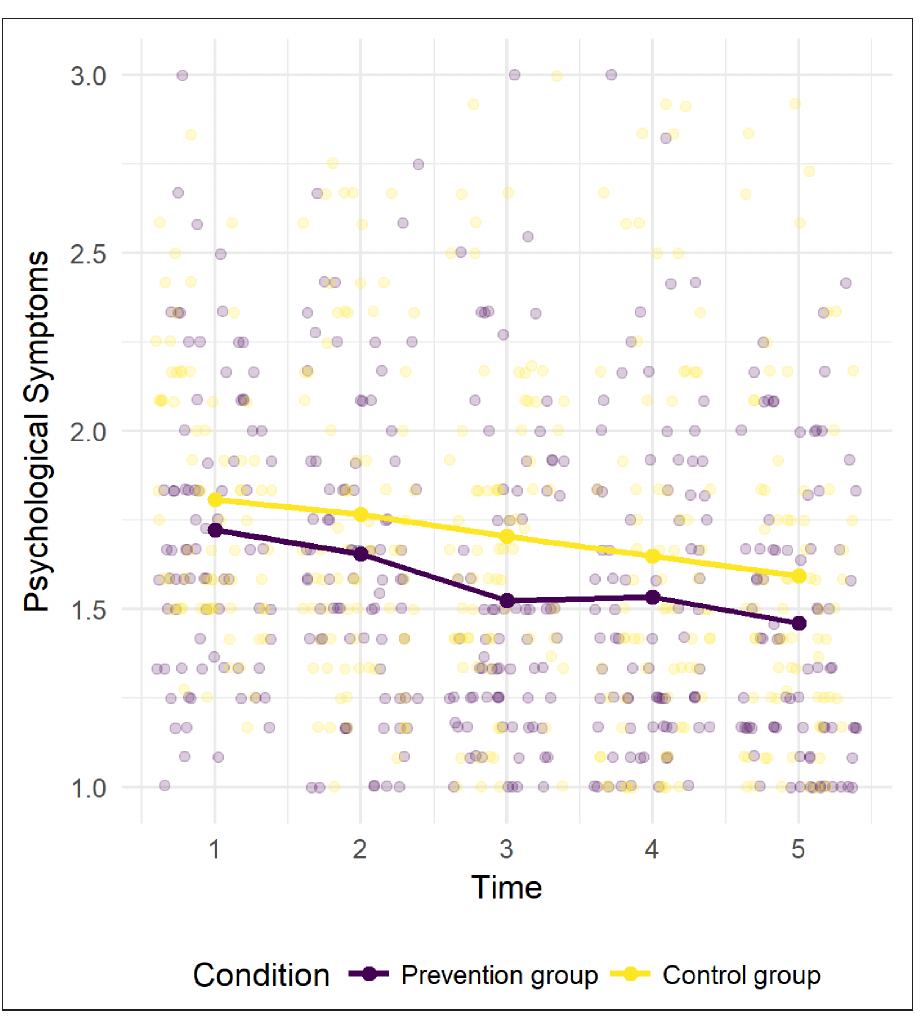
Figure 3: Visualisation of the effects of the stress prevention programme on psychological stress-related symptoms (X-axis = Time of measurement; Y-axis = Aggregated psychological stress-related symptoms; purple line = prevention group; yellow line = non-treatment control group; dots = Psychological stress-related symptoms for each participant at each time of